Question: Write a caption explaining this figure to a reader.
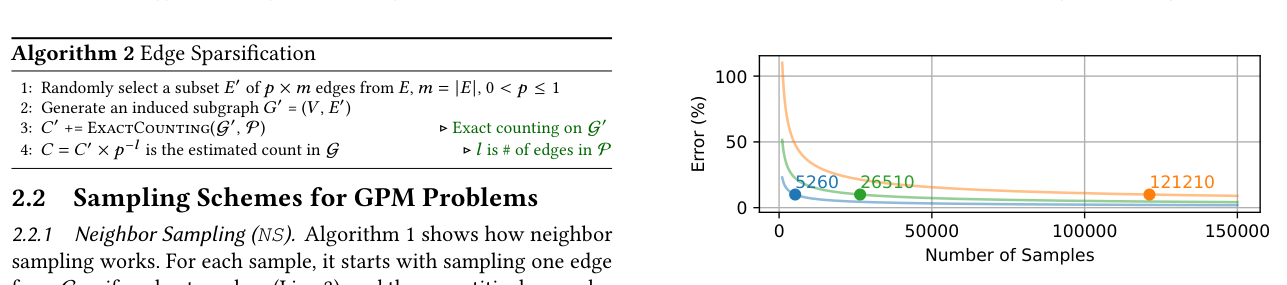
Answer: Three different runs (three curves) of Arya’s ELP predic- tion given the LiveJ graph and triangle pattern. With an error bound of 10%, the curves give dramatically different prediction on the number of samples 𝑁𝑠: 5,260, 26,510 and 121,210. This leads to a 25× performance difference in the sampling execution phase.